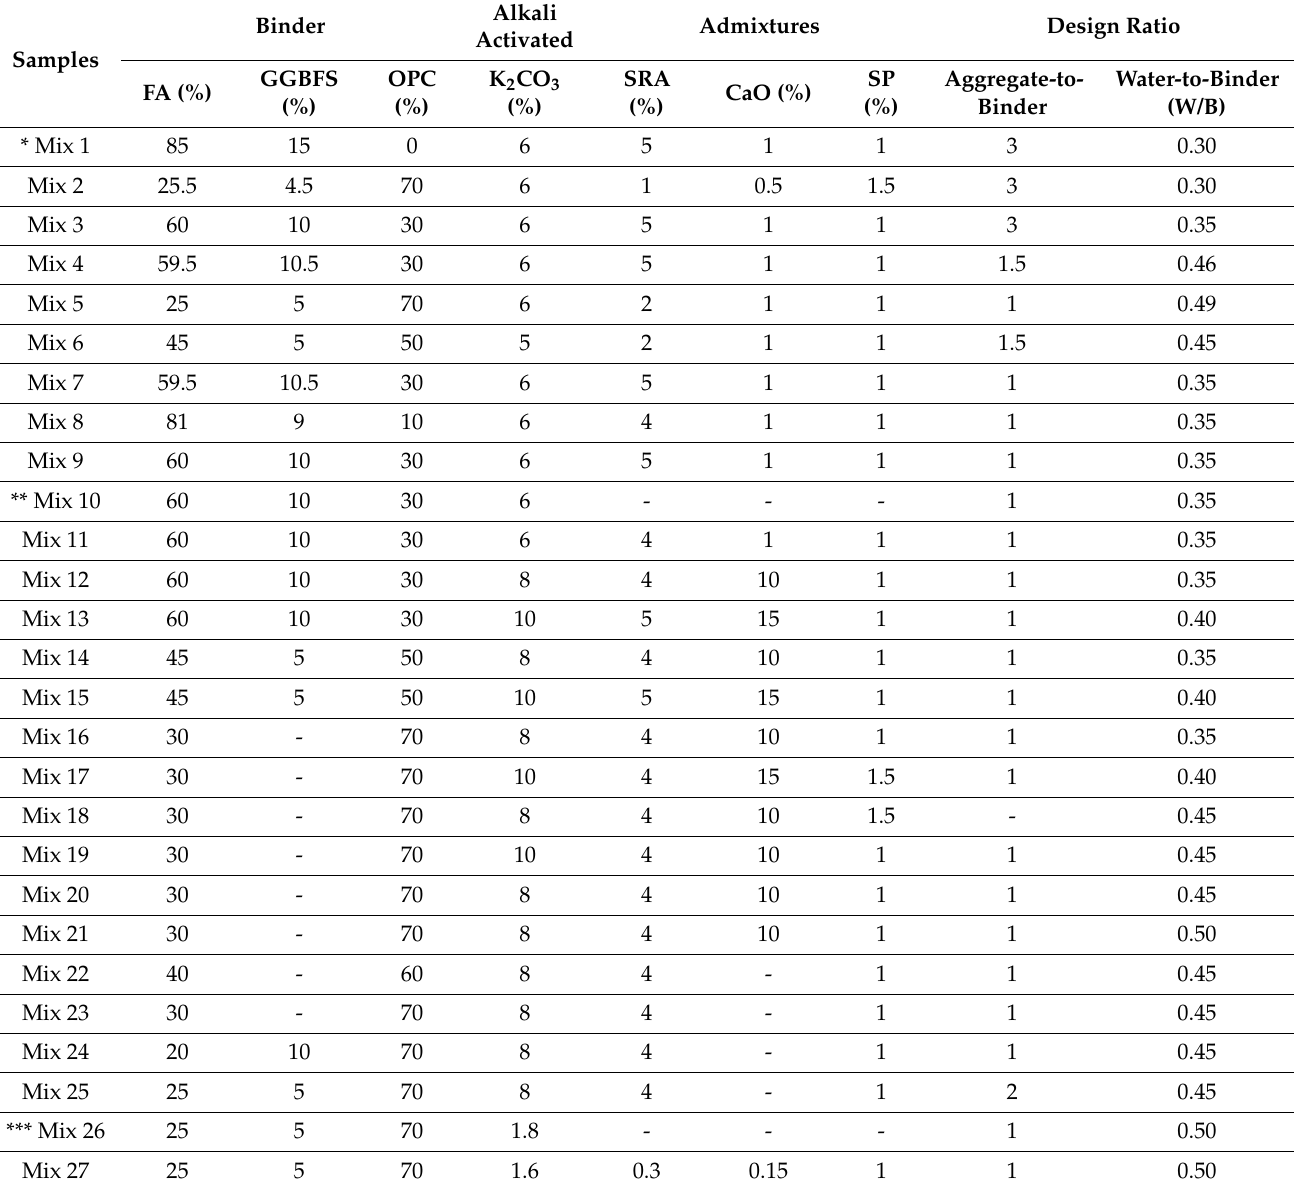
Table 2. Mix composition and design of one-part Alkali Activated Materials